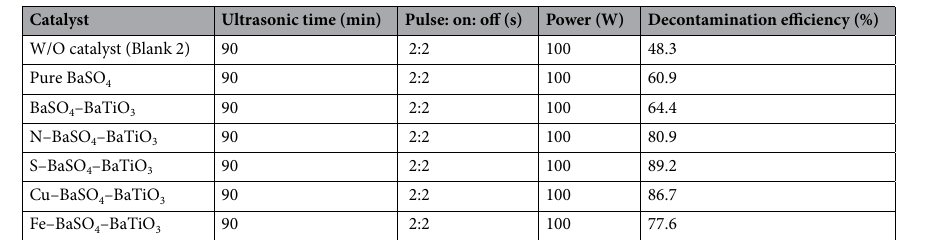
Table 3. Piezoelectric catalytic capability of Pure BaSO 4 , BaSO 4 –BaTiO 3 , Cu–BaSO 4 –BaTiO 3 , Fe–BaSO 4 – BaTiO 3 , S–BaSO 4 –BaTiO 3 , N–BaSO 4 –BaTiO 3 nanostructure for degradation of